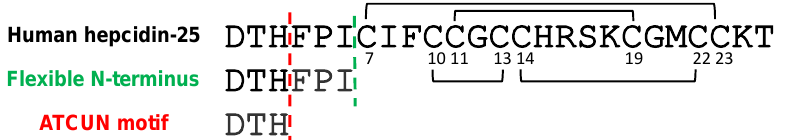
Figure 1. Amino acid sequences of human hepcidin-25 [5], its N-terminus (green) and the ATCUN motif (red).